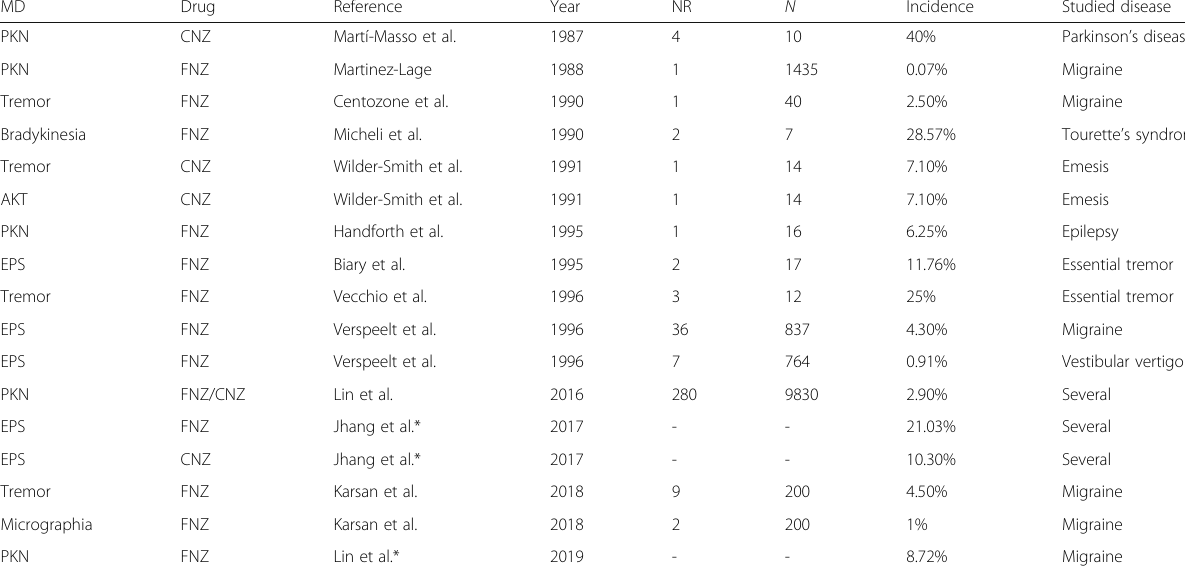
Table 3 Incidence of some abnormal movements in the